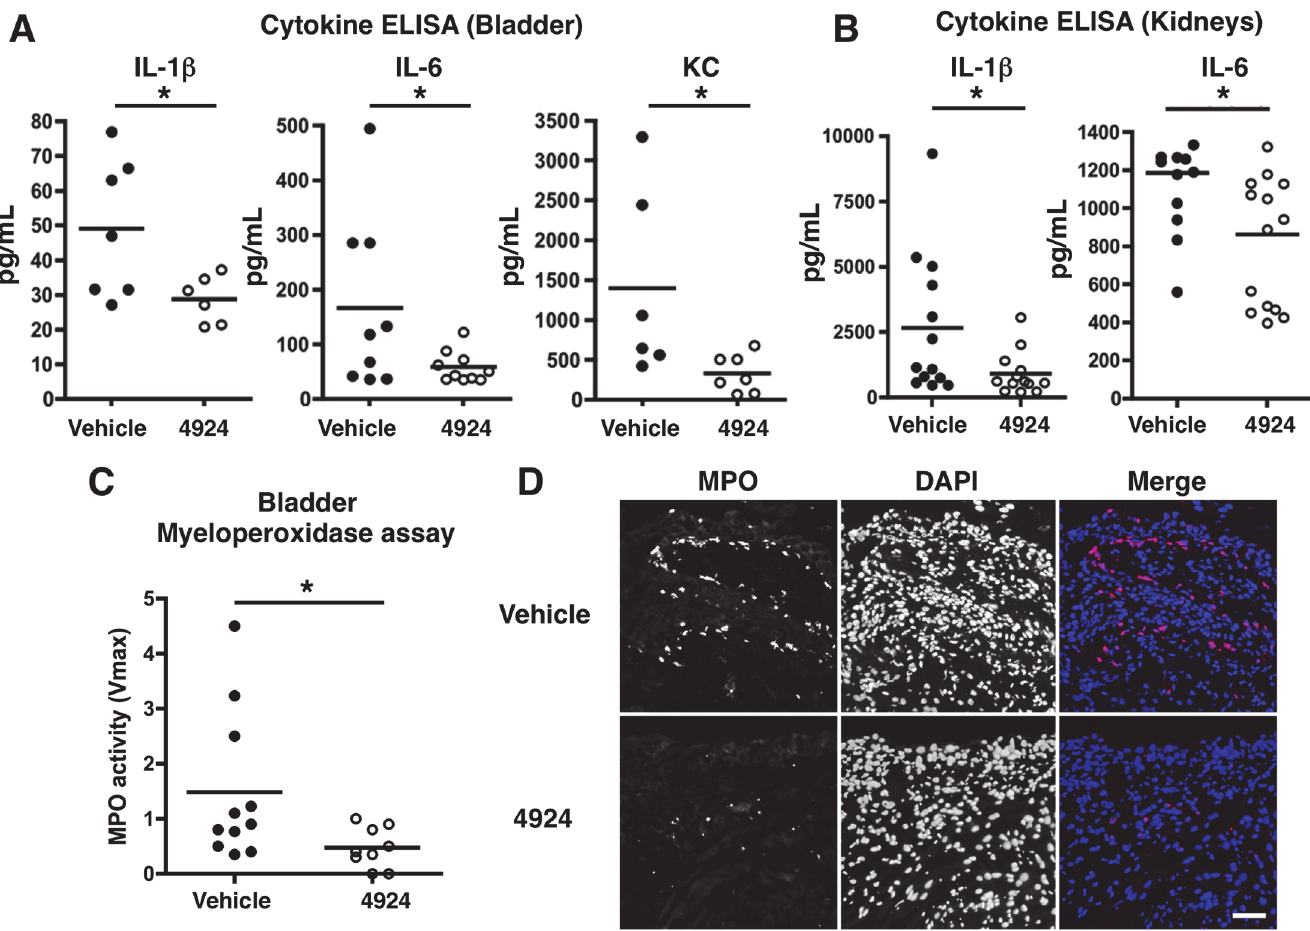
Fig 5. Reduced UPEC-mediated inflammatory damage to bladder epithelium with AKB-4924 pretreatment. ( A, B ) ELISA analysis shows pro- inflammatory cytokines IL-6, IL-1 β or KC in the bladders or kidneys are reduced in AKB-4924 treated mice 18 – 24 h post UPEC CFT073 infection. Results are compiled from more than two independent experiments (n > 3 per group). ( C ) Myeloperoxidase (MPO) assay of bladder supernatants (n = 9 – 11) indicates significant decrease in MPO activity in AKB-4924 pre-treated bladders 18h post UPEC CFT073 infection; Error bar = S.E.M * P < 0.05, Student ’ s two-tailed unpaired t-test. ( D ) Representative immunolocalization images of bladder MPO (red) and nuclei (DAPI, blue) of 18 h UTI89-infected mice with or without 4924 pre-treatment (n = 3 – 4 per group). Scale bar = 50 μ m.